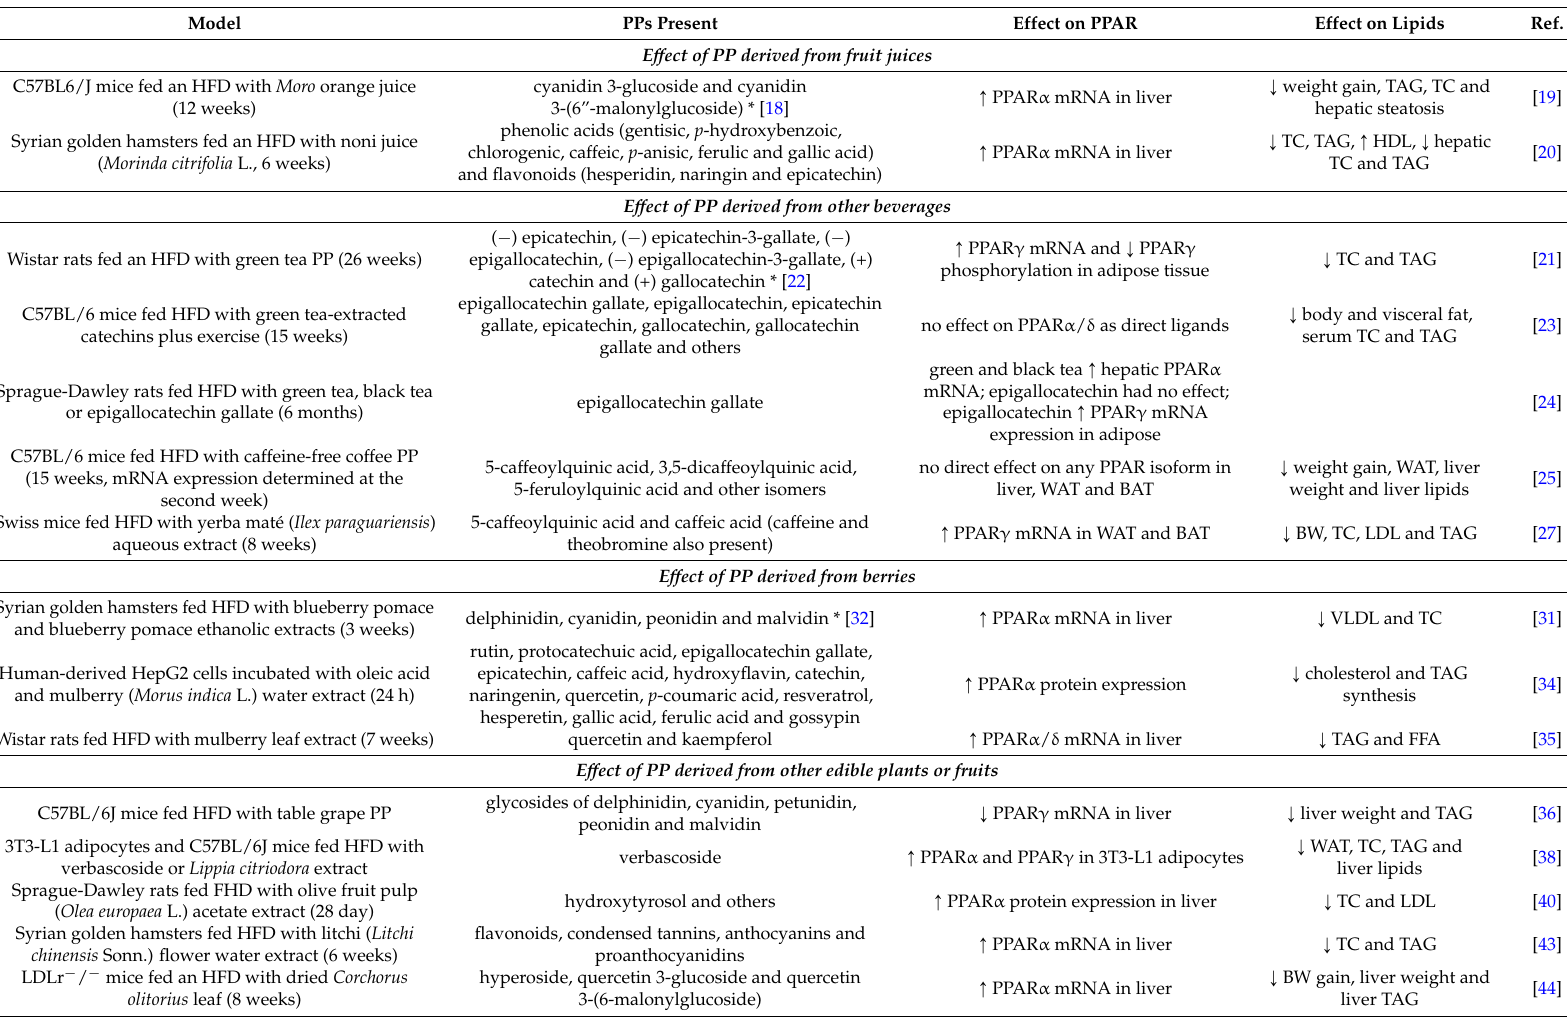
Table 1. Concise description of the studies described in the text highlighting the effects on PPAR and on body and serum lipids. References are listed by PP source. Model PPs Present Effect on PPAR Effect on Lipids